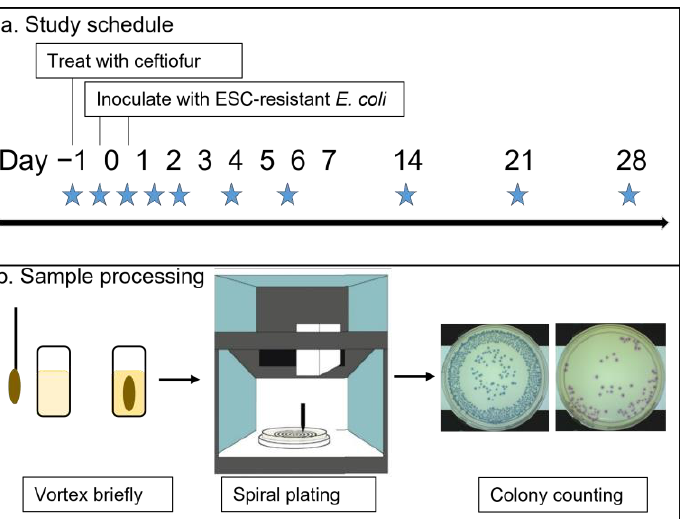
Figure 1. Overview of in vivo model for assessing effect of novel strategies on ESC-resistant E. coli. ( a ). Timeline of the study regarding treatments and sampling of pigs. Blue stars represent days rectal swabs were collected. The first inoculation with ESC-resistant E. coli was day 0 (i.e., 7 days after weaning). ( b ). Protocol of laboratory processing of samples for quantification of total E. coli and ESC-resistant E. coli from rectal swabs (calculated as CFU/g). Blue colonies represent E. coli on CHROMagar ™ ECC agar while pink colonies represent ESC-resistant E. coli on CHROMagar ™ ESBL agar.